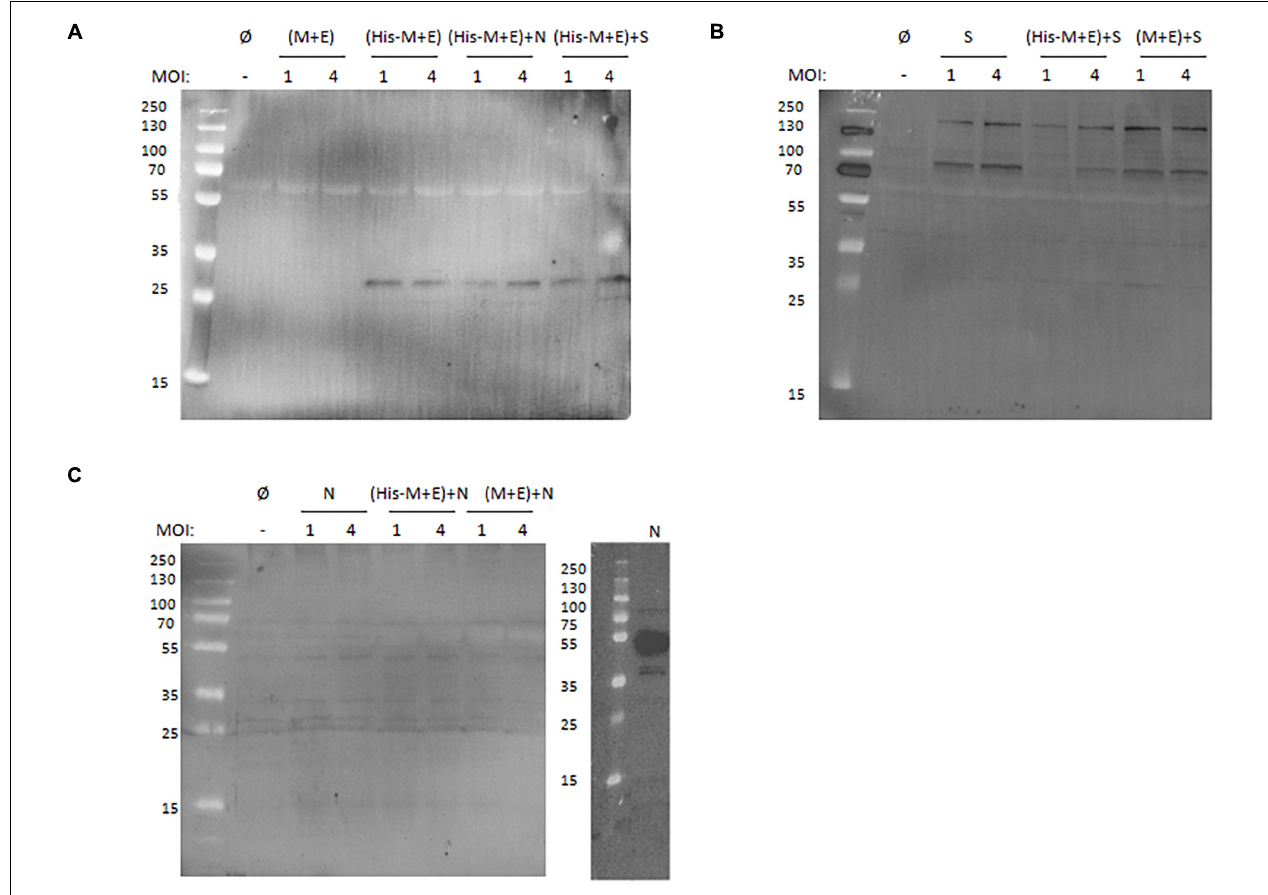
FIGURE 2 | Western blotting analysis of SARS-CoV-2 proteins secreted from insect cells. (A) Anti-His antibody detection of culture media collected from cells infected with (M + E) BV and (His-M + E) BV alone or in presence with N BV or S BV. (B) Anti-S antibody detection of culture media collected from cells infected with S BV alone or in the presence of (His-M + E) BV and (M + E) BV. (C) Anti-N antibody detection of culture media collected from cells infected with N BV alone or in the presence of (His-M + E) BV and (M + E) BV (left) and cell lysate from cells infected with N BV (right). In each case, MOI = 1 and MOI = 4 were tested. “Ø” denotes negative control (medium collected from uninfected insect cells). SARS-CoV-2, severe acute respiratory syndrome coronavirus 2; BV, baculovirus; MOI, multiplicity of infection.